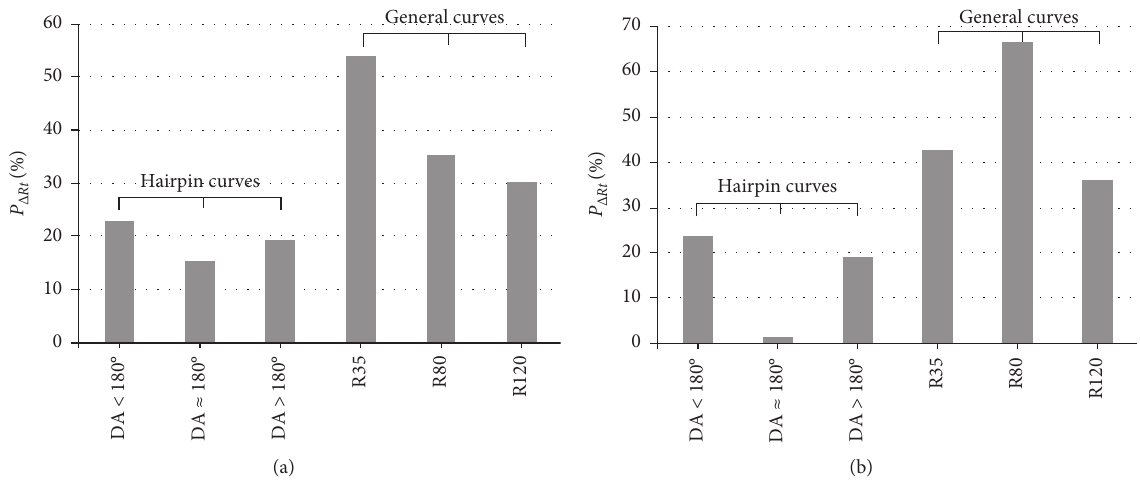
Figure 16: Histogram of P △ Rt for hairpin curves and general curves. (a) Left-hand curves; (b) right-hand